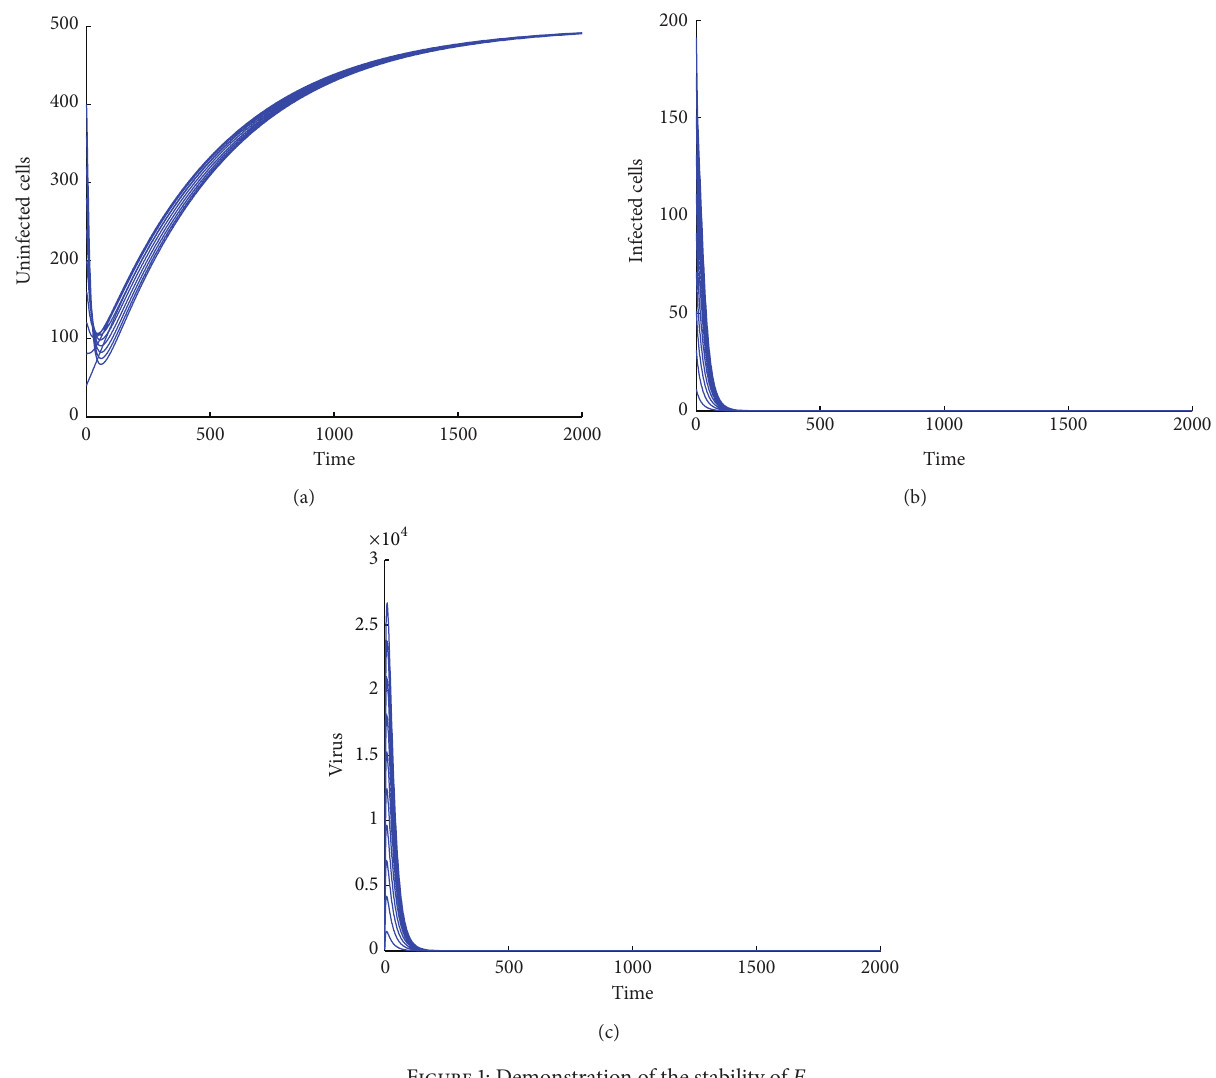
Figure 1: Demonstration of the stability of 𝐸 0